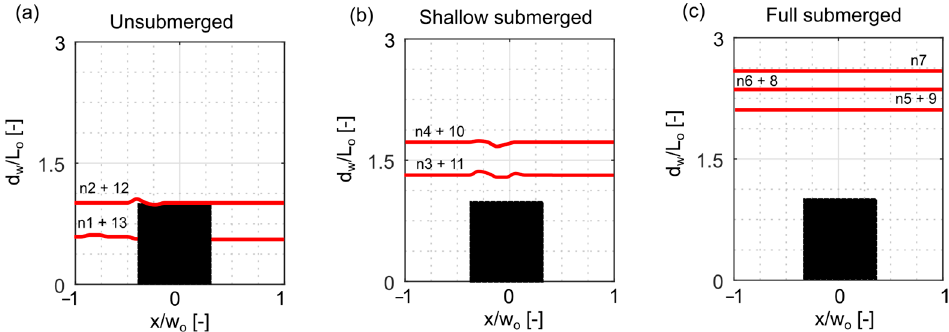
Figure 6. Extent of submergence of the obstacle and indication of discharge interval (n): ( a ) unsub- merged, ( b ) shallowly submerged, and ( c ) fully submerged.